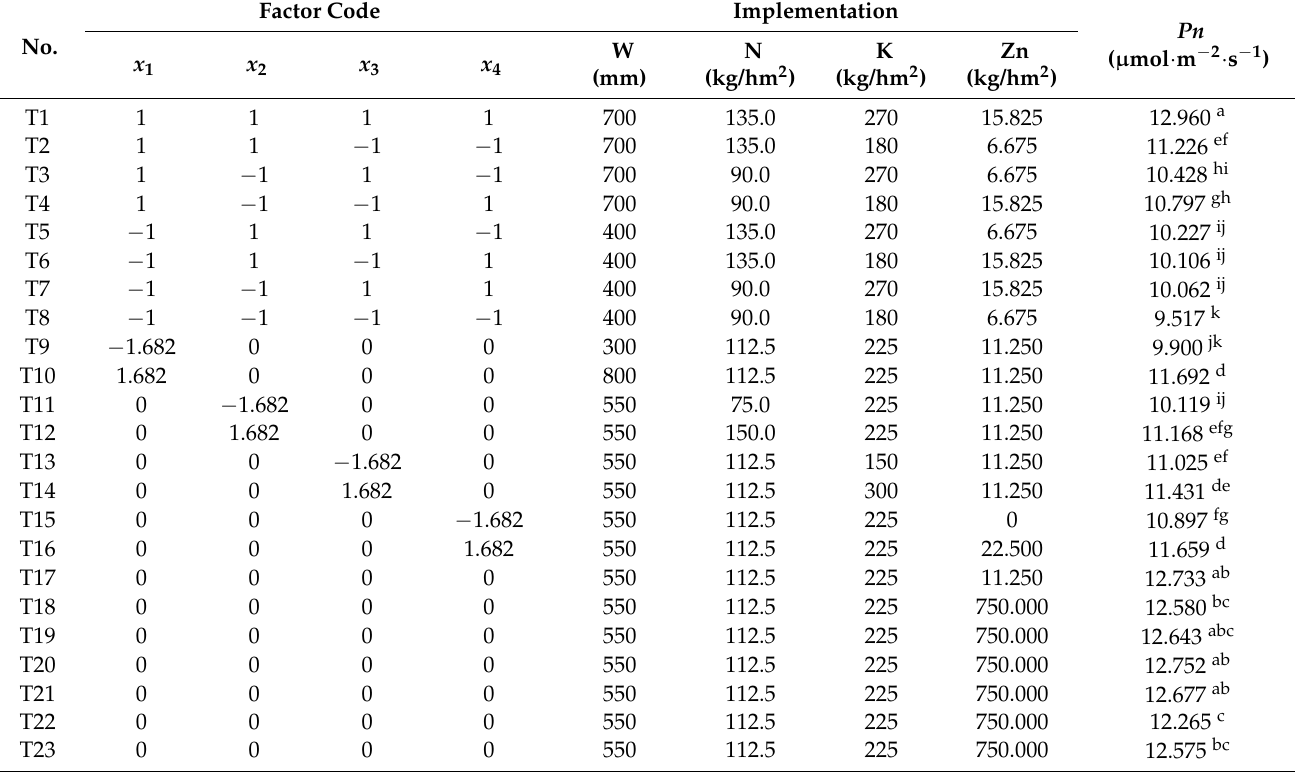
Table 3. Net photosynthetic rate ( Pn ) change for different